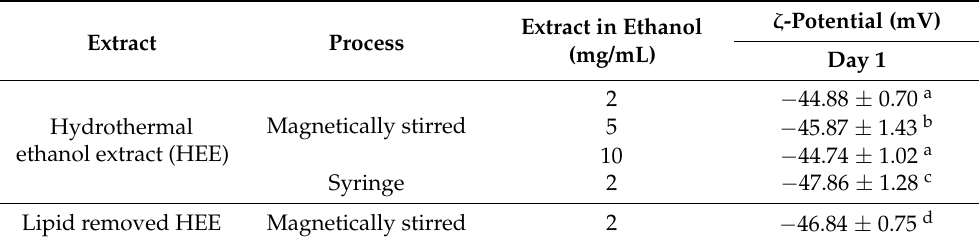
Table 1. ζ -potential measurements for colloidal particle dispersions at pH 5.96 ± 0.58. Different letters indicate statistically significant differences, p = 0.05, ANOVA.